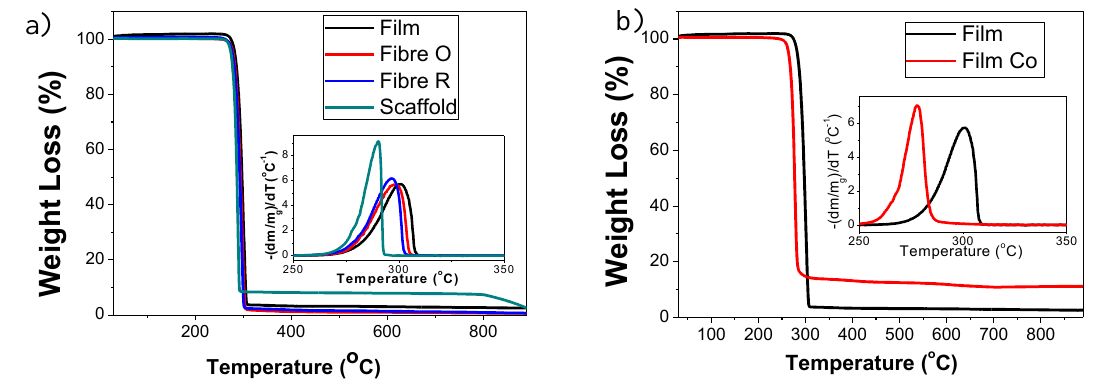
Figure 4. TGA thermograms and corresponding first derivatives for ( a ) different neat PHBV morphologies and ( b ) PHBV films and films composites.